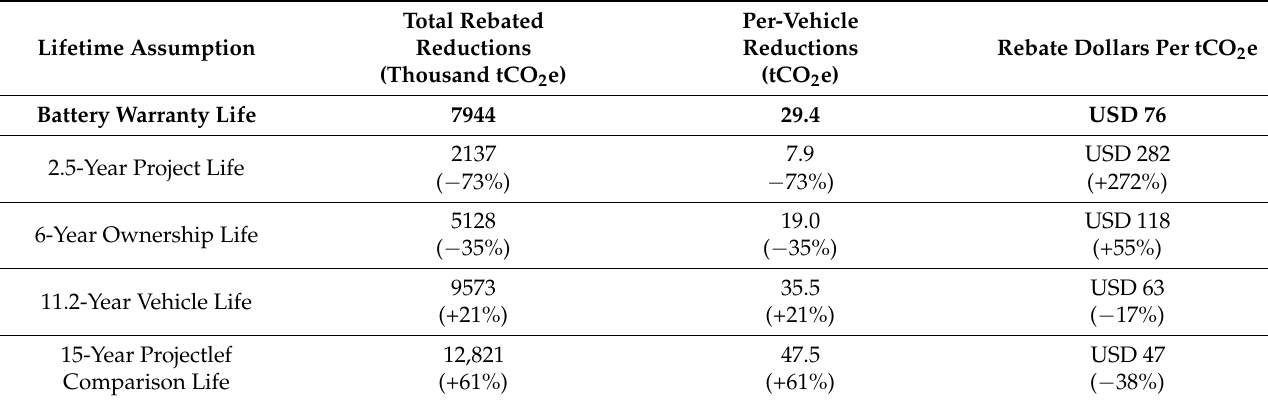
Table 3. Lifetime Assumption